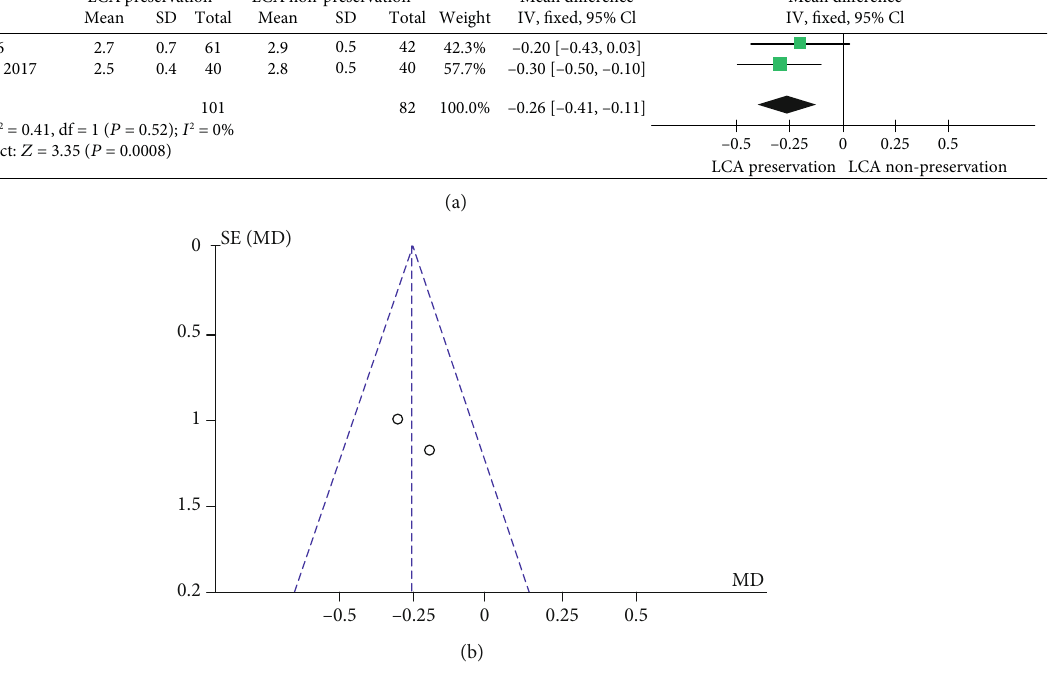
Figure 7: (a) Forest plot of time for intestinal function recovery; (b) funnel plot of time for intestinal function